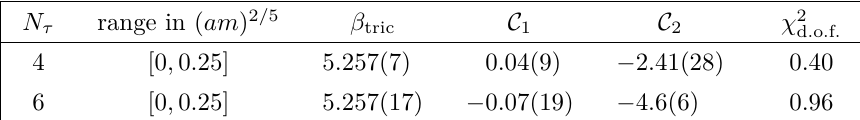
Table 2. Fits of the data in figure 6(a) to eq.